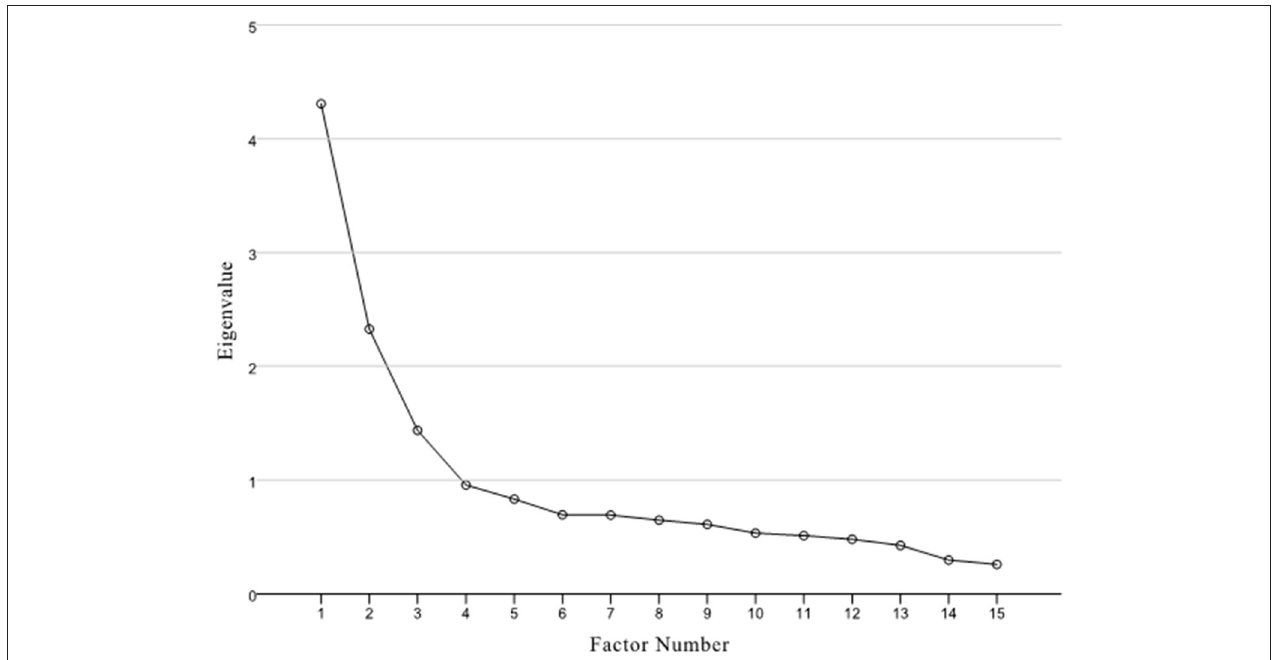
FIGURE 1 | Scree plot for the EFA in Sample